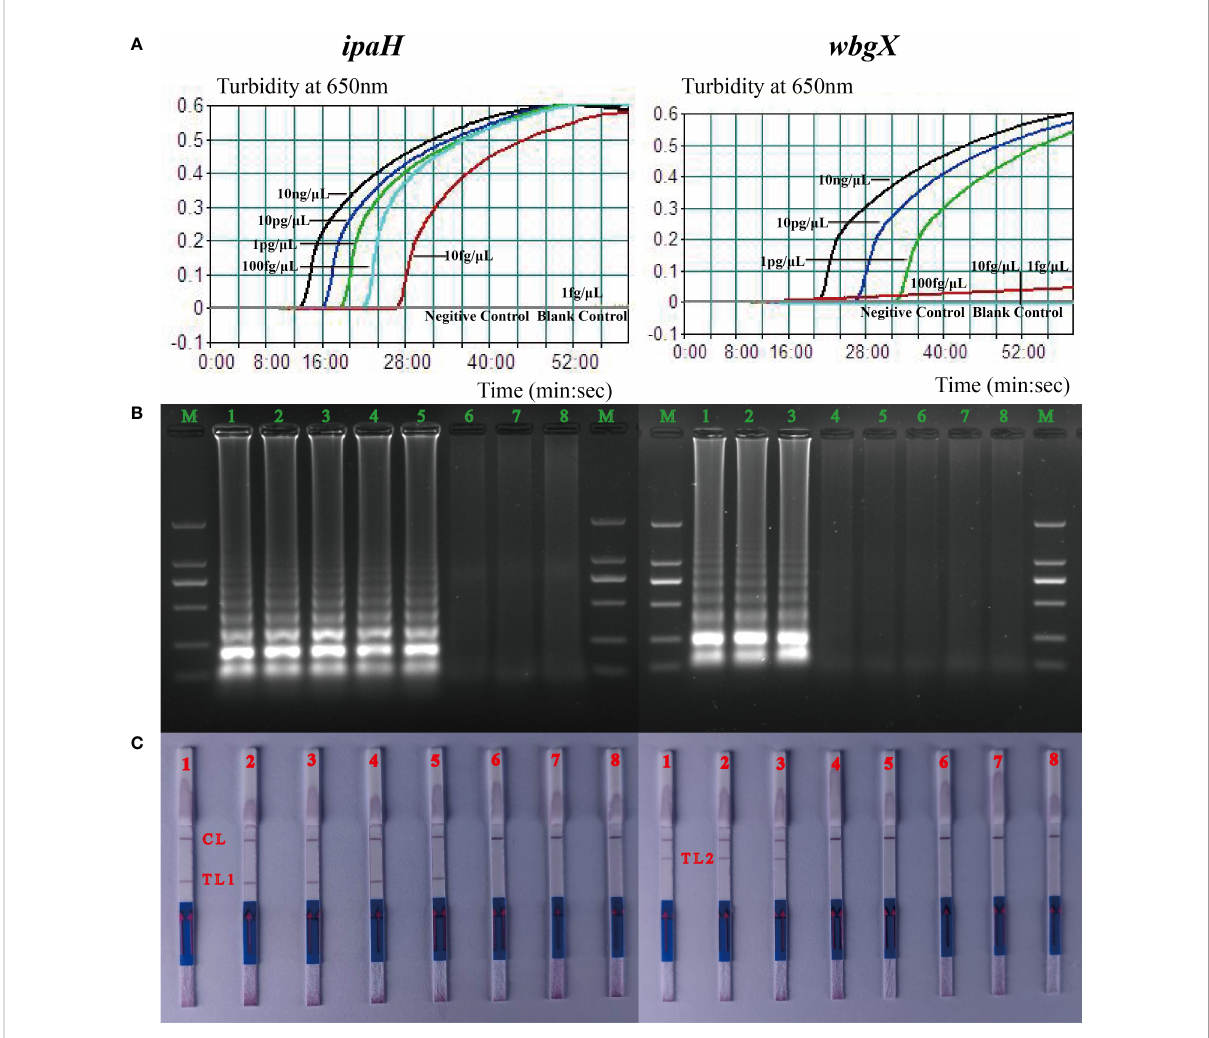
FIGURE 2 Detection limits of the ipaH and wbgX genes of the singlex MCDA-LFB assay. The six dilution templates of S. sonnei CMCC 51081 including 10 ng, 10 pg, 1 pg, 100 fg, 10 fg, and 1 fg were subjected to MCDA reactions to detect limits of ipaH and wbgX genes. (A) Real-time sensitivity of the singlex MCDA assay of two genes monitored by measuring the turbidity (optimal density at 650 nm). The turbidity >0.1 was considered positive for the two genes. The detection limits were 10 fg/ m L for ipaH and 1 pg/ m L for wbgX genes. (B) Gel electrophoresis was applied for analysis of the sensitivity of ipaH and wbgX genes. Strips M, DNA marker DL2000; Strips 1 – 6, PCR results for six dilutions; Strips 7, negative control; Strips 8, blank control. In agarose gel analysis of the two genes, the MCDA products showed the typical ladder-like pattern amplicons, and the detection limit matched the turbidity data. (C) LFB applied for analysis of ipaH and wbgX genes MCDA products. Biosensors 1 – 6, MCDA results for six dilutions; Biosensor 7, negative control; Biosensor 8, blank control. CL (control line), T L1 (test line 1), T L2 (test line 2). The positive results were observed at Biosensor 5 with the red line of T L1 and Biosensor 3 with the red line of T L2 which meant the detection limits of the ipaH gene was 10 fg/ m L for and wbgX gene was 1 pg/ m L. The detection limits matched the turbidity data and gel electrophoresis